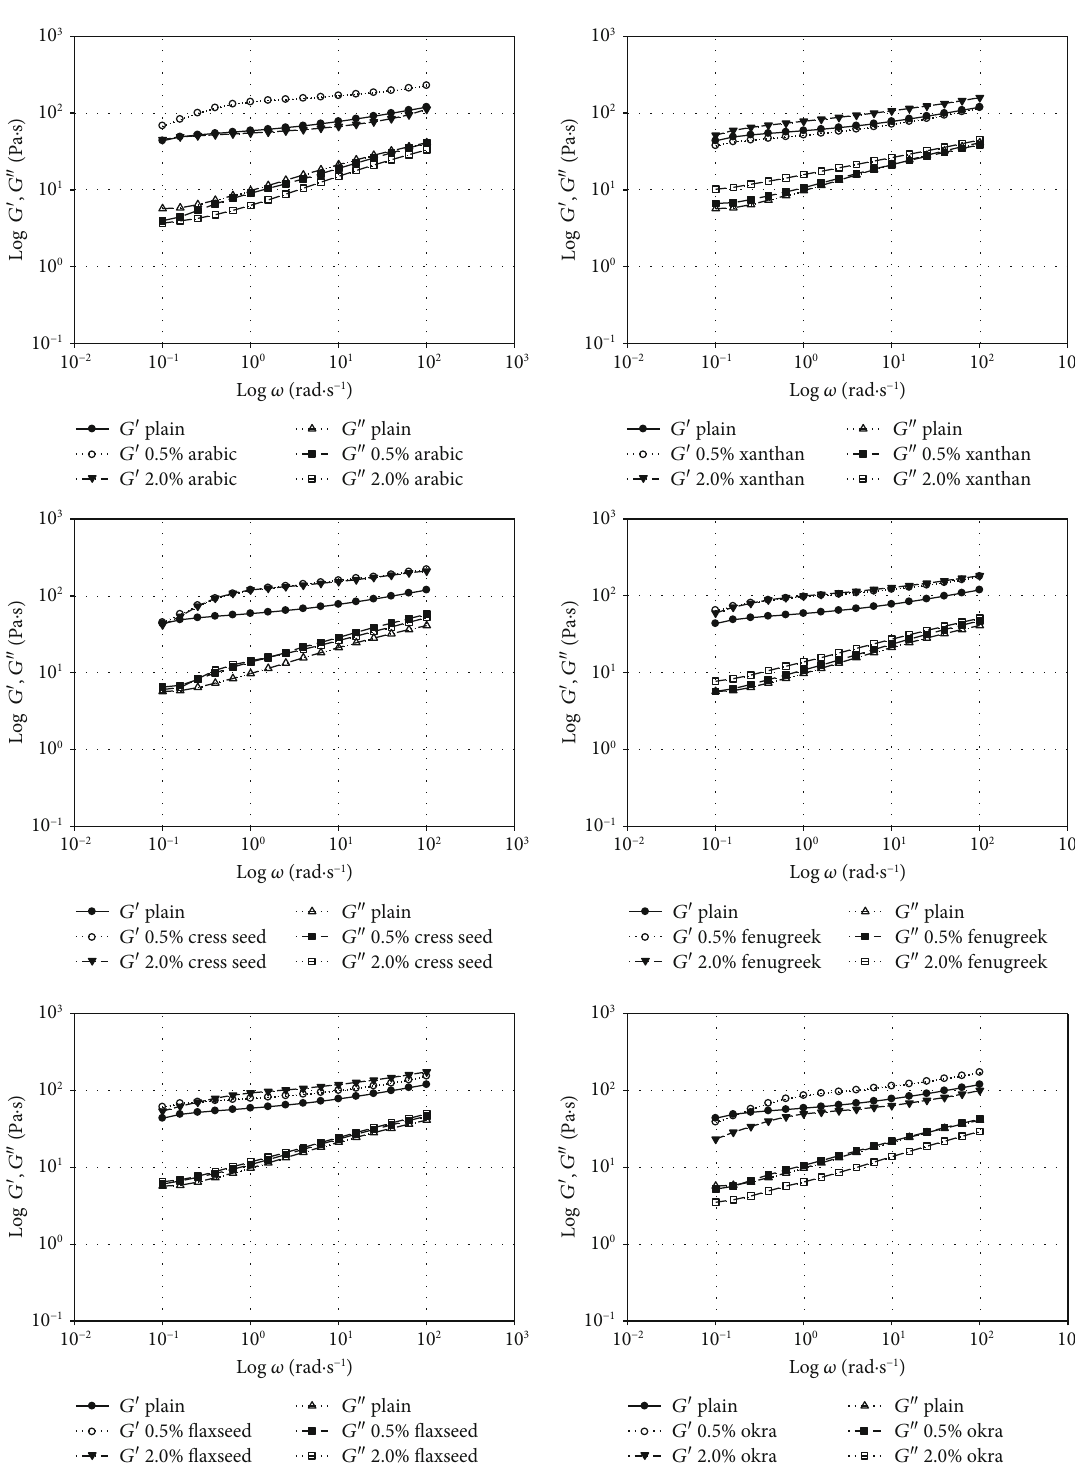
Figure 1: Plots of log G ′ , G ″ versus log ω of sweet potato starch gum blends at di ff erent gum